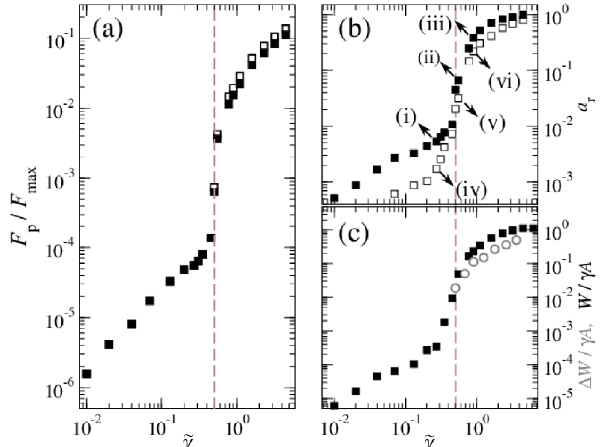
Fig. 2 (a) Pull-off force F p , (b) relative contact area a , and (c) r work of adhesion W (closed squares) as well as energy hysteresis Δ W (grey open circles) for one realization of the default surface. Open symbols in panel (a) relate to contacts in which the elastic body was retracted when the normal load reached zero for the first time, while closed symbols relate to earlier retractions right after the tensile stress was maximal. Both data sets overlap for γ < 0.5. Closed and open symbols in panel (b) show a at zero r load and just before snap-off, respectively. Variables were normalized as follows: F p is expressed in units of F max , which is the maximum tensile stress of the cohesive zone model times the nominal contact area, while γ is divided by the elastic, full-contact, areal energy density . v Finally, W and ∆ W are normalized by γ fce times the nominal contact area A